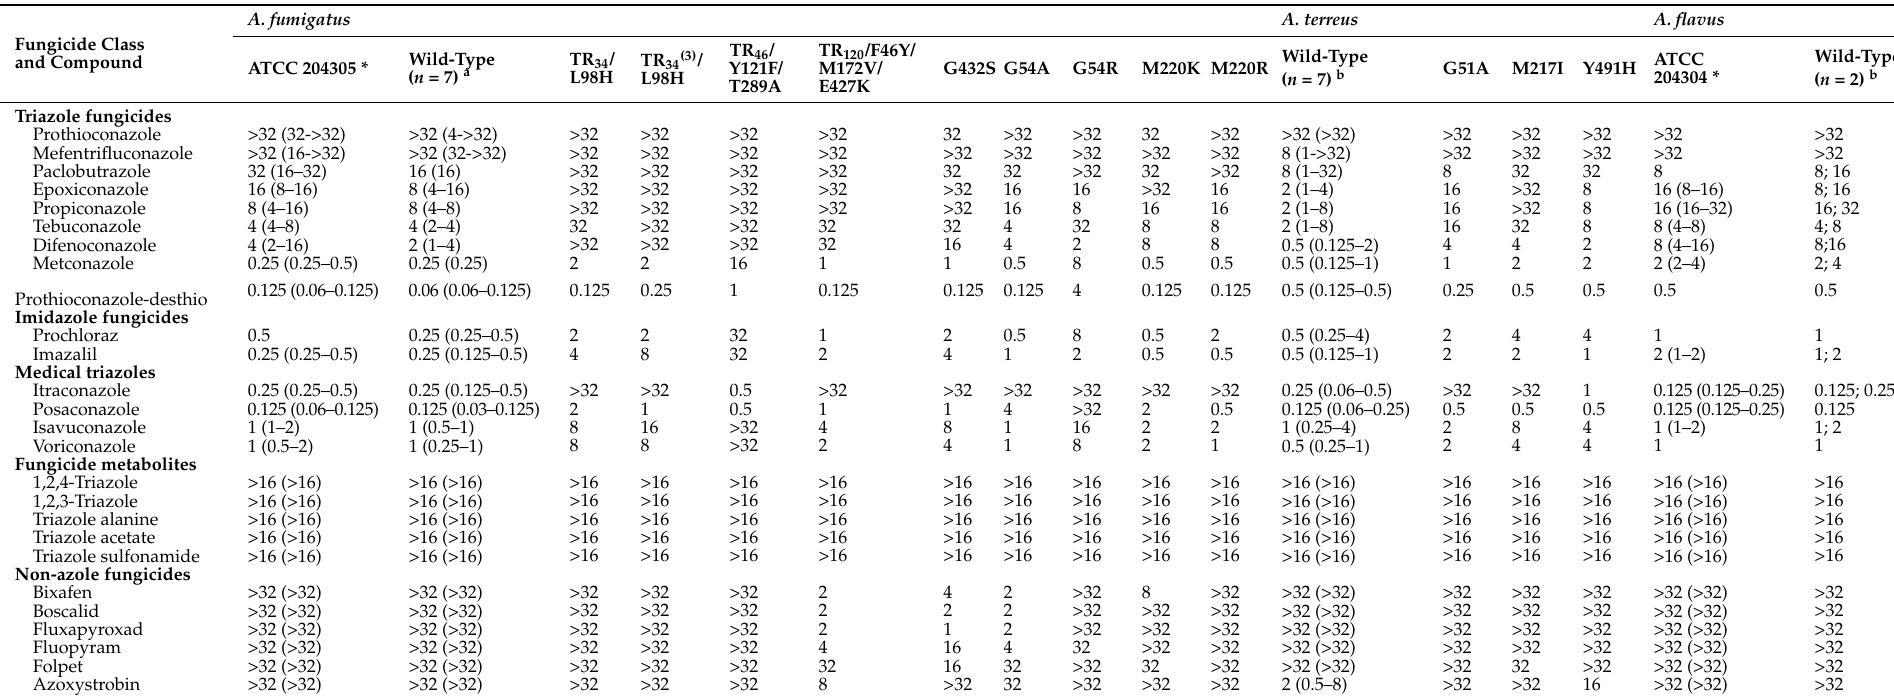
Table 1. In vitro activity (EUCAST MICs (mg/L) with visual complete inhibition endpoint) of 11 azole fungicides, four medical triazoles, five azole fungicide metabolites and six non azole fungicides against wild-type and cyp51A mutant isolates of three Aspergillus